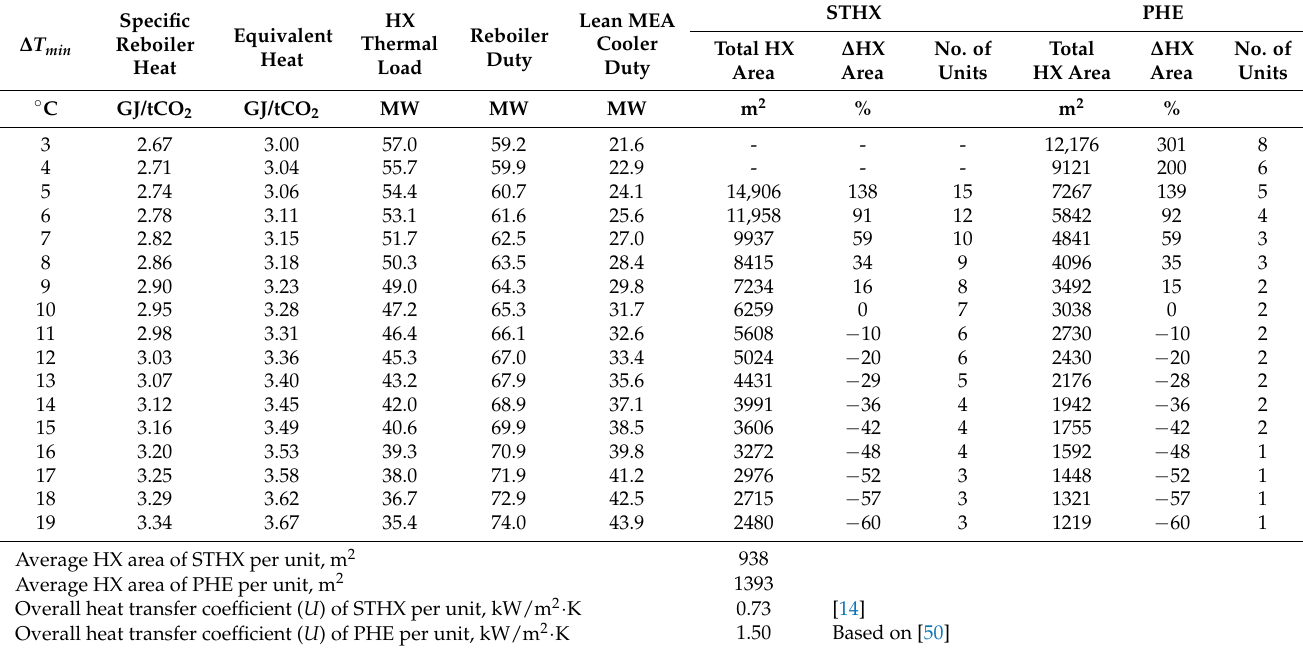
Table 13. The influence of the lean/rich heat exchanger ∆ T min on the thermal load and area of the required heat exchangers (cement plant lean vapour recompression CO 2 capture